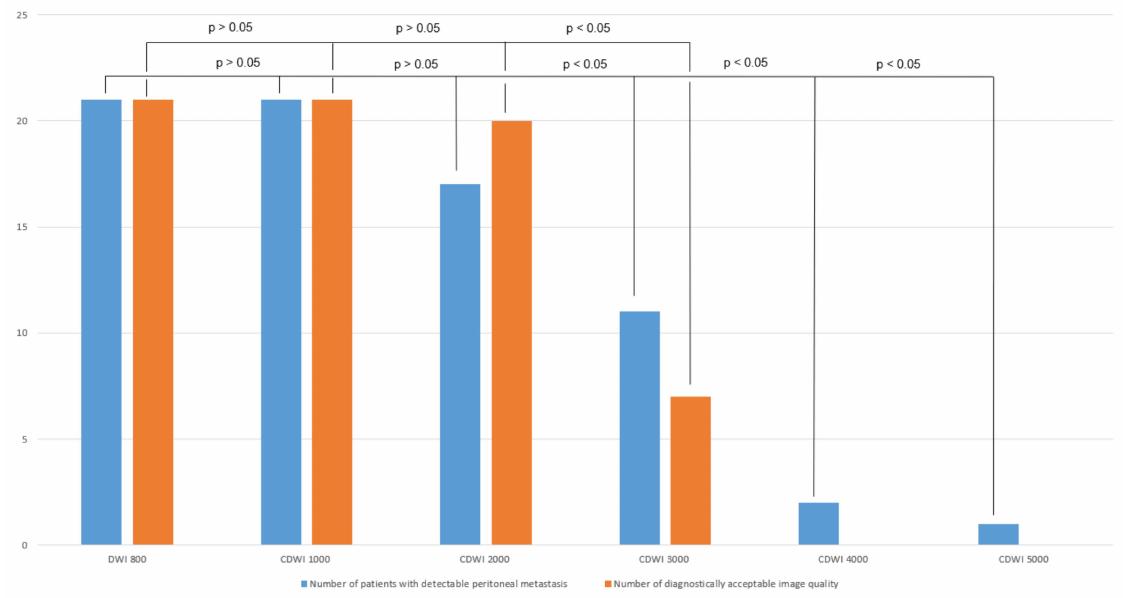
Figure 2. Bar graph showing the number of detected peritoneal carcinomatosis and acceptable image quality in DWI/c-DWI with b-values of 800–5000 s/mm 2 . There were no significant differences between b = 800 and b = 1000–2000 s/mm 2 in terms of lesion detection or image quality. However, there was a statistically significant decrease beginning at b = 3000 s/mm 2 in both